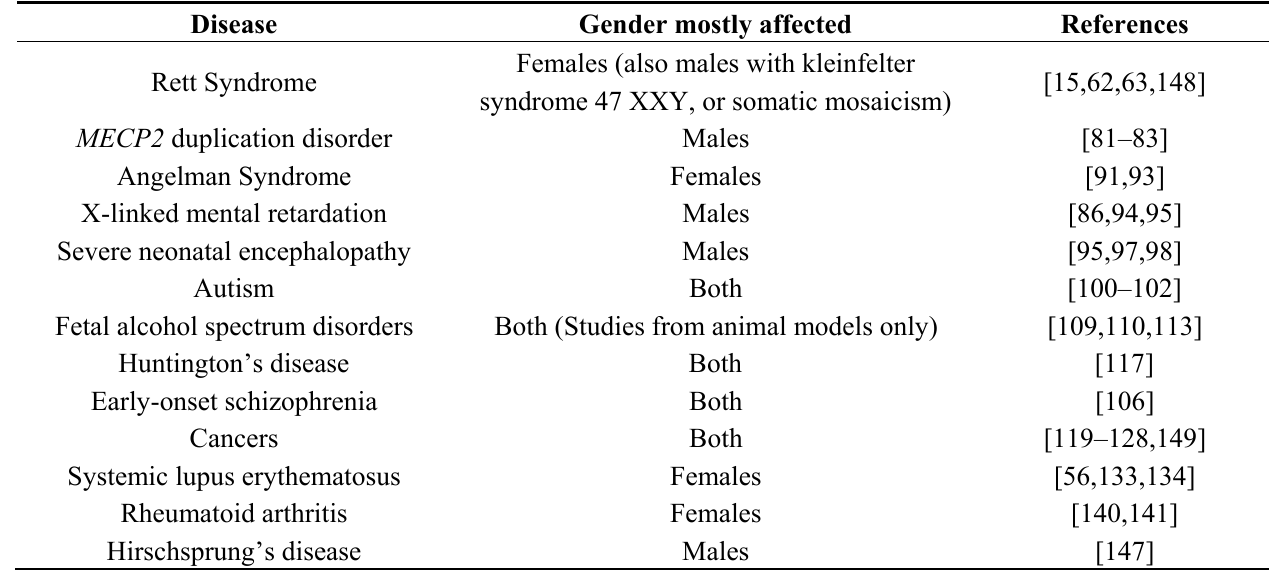
Table 1. Human diseases associated with Methyl CpG binding protein 2 (MeCP2) and gender mostly